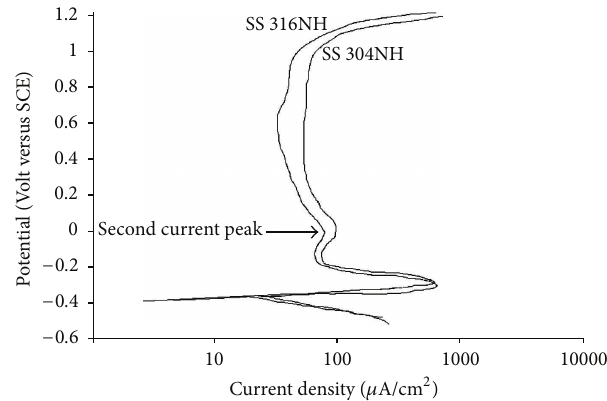
Figure 9: Anodic polarization curve for types 304NH and 316NH austenitic stainless steels, in a solution of 0.5 M sulfuric acid ( H